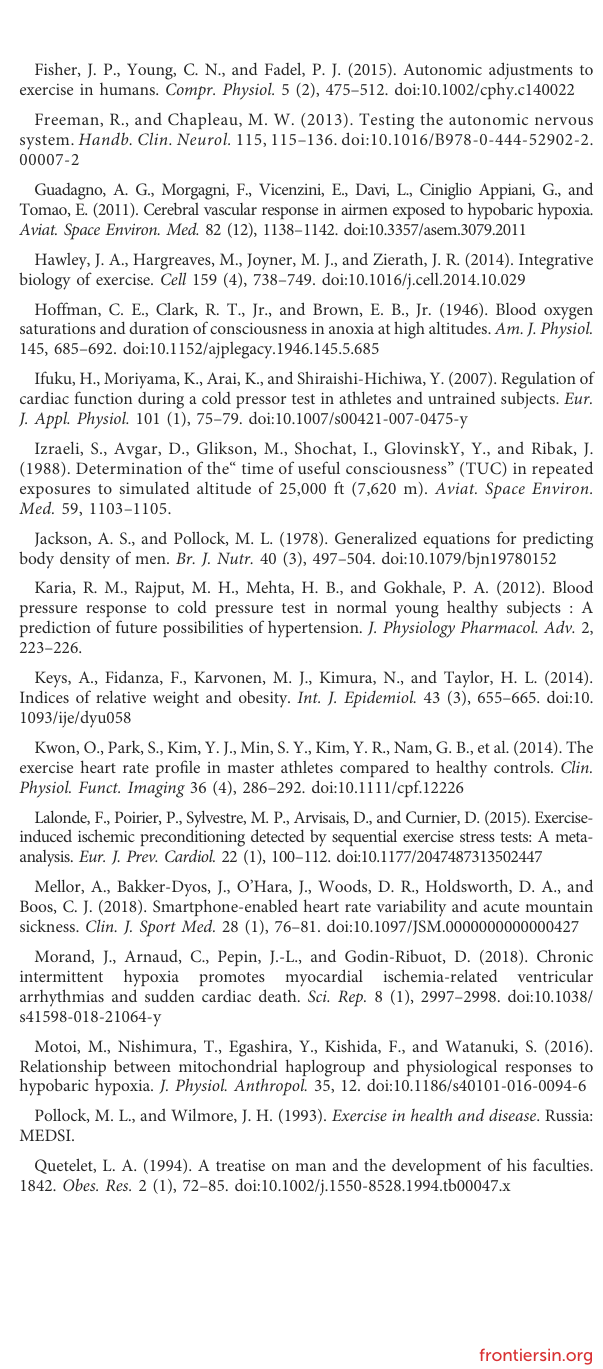
SUPPLEMENTARY FIGURE S1 An example of the graphical behavior of R-R. ms,